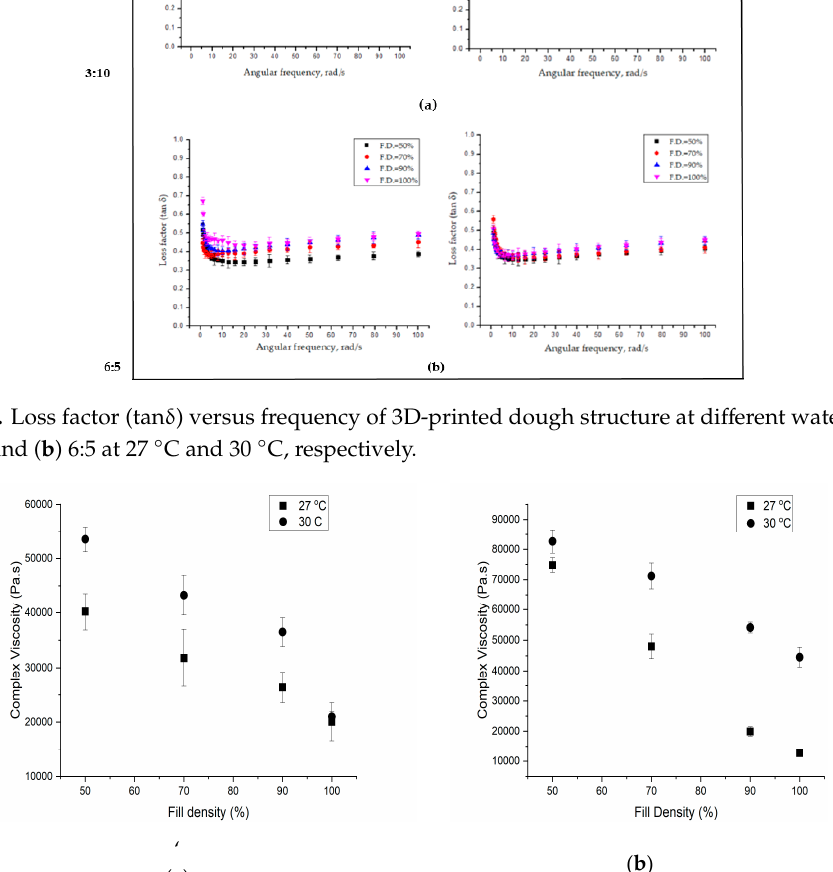
Figure 6. Complex viscosity values at different fill densities, temperatures, and ( a ) water butter ratios: 3:10 and ( b ) water butter ratio of 6:5. Values are mean ± standard deviation (n = 3).